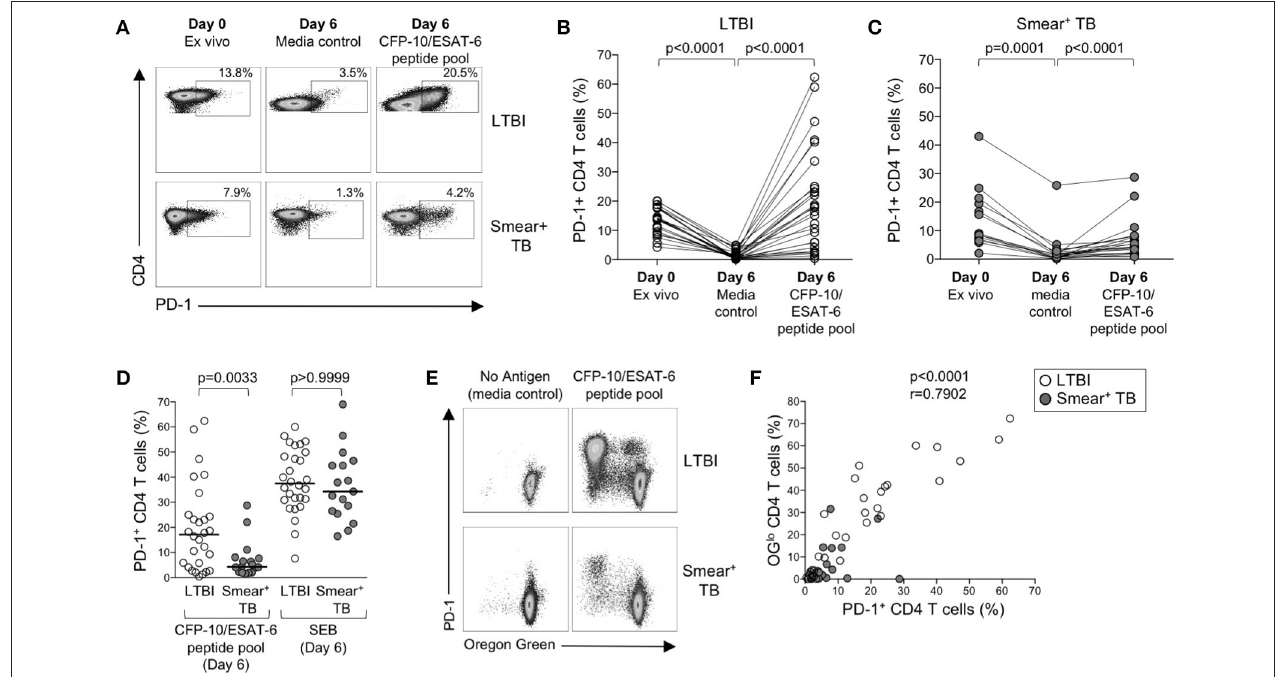
FIGURE 7 | PD-1 expression is induced on CFP-10/ESAT-6-specific CD4T cells proliferating in vitro . Proliferation assays performed as described in Figure 6 . PD-1 expression was measured by flow cytometry on total CD4T cells and CFP-10/ESAT-6-specific proliferating (OG lo ) CD4T cells on day 6 of culture. (A) Flow